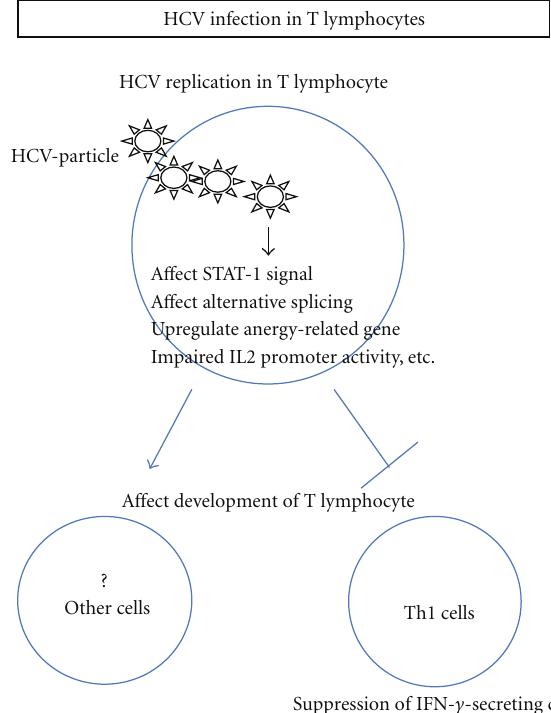
Figure 2: The schema of the biological significance of HCV repli- cation in T cells is shown. The representative e ff ects of lymphotropic HCV on T cells are shown in this